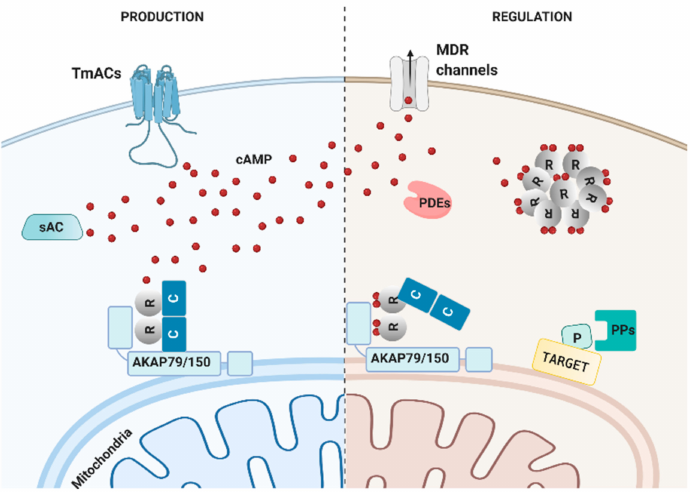
Figure 1. Compartmentalization mechanisms of the cAMP/PKA axis. Cyclic AMP can be produced at the plasma membrane by transmembrane adenylyl cyclases (tmACs) or intracellularly, by the soluble adenylyl cyclase (sAC). Once produced, the levels of cAMP are regulated by 3 main mechanisms: degradation by phosphodiesterases (PDEs), extrusion from the cells to the extracellular milieu by multi drug resistance channels (MDR channels) or buffering by RI alpha-constituted membraneless organelles. A final, cAMP-independent, regulatory step is exerted by the action of phosphatases (PPs) that by dephosphorylating PKA-phosphorylated targets effectively terminate the cascade. Created with